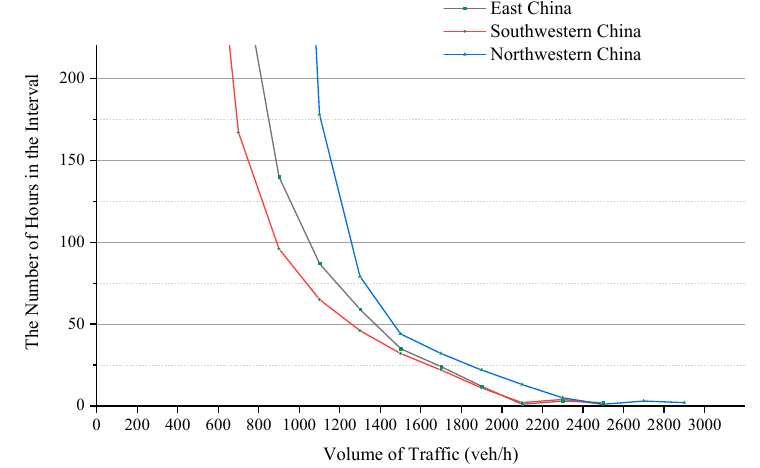
Figure 2. Number of hours in the various traffic volume intervals.